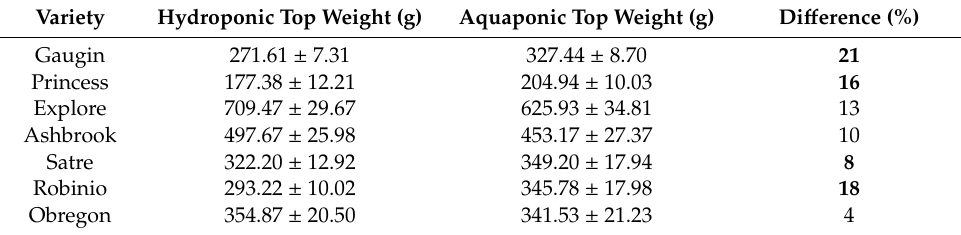
Table 6. Hydroponic vs. aquaponic NFT lettuce production results—winter 2010. The results include the mean leaf fresh weight (top weight) gain ± standard error for each system, and the percentage di ff erence between the two systems for each variety. The di ff erences in the bold font indicate that the aquaponics system mean was larger than the hydroponic system